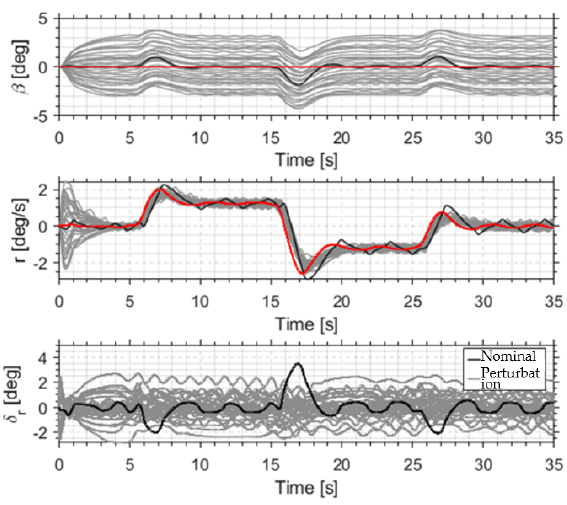
Figure 23. Perturbation simulation of rolling channel at 12 km altitude and 1.2 Mach